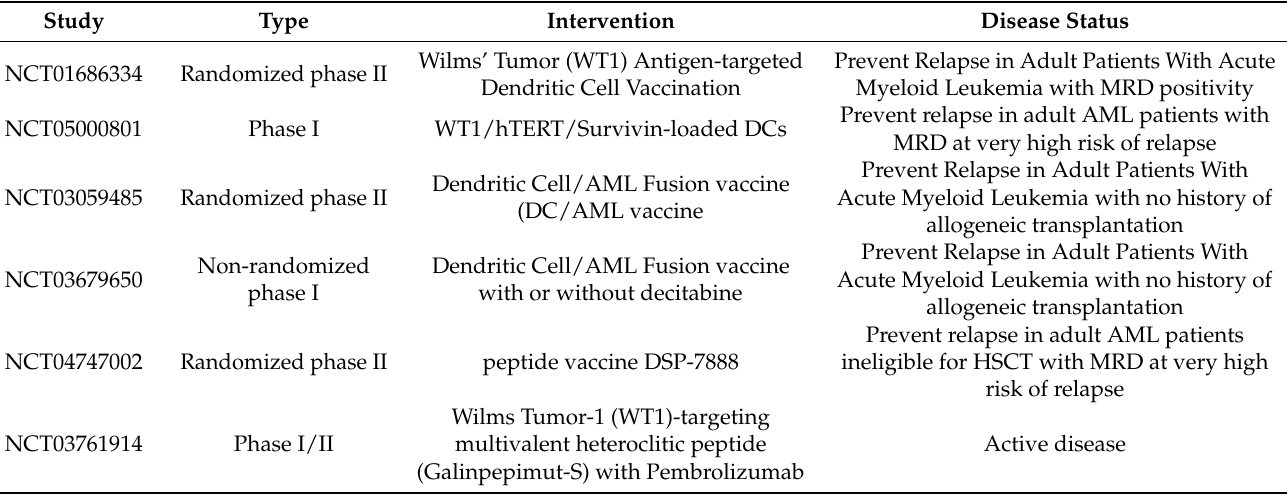
Table 2. Ongoing trials about vaccine therapy in